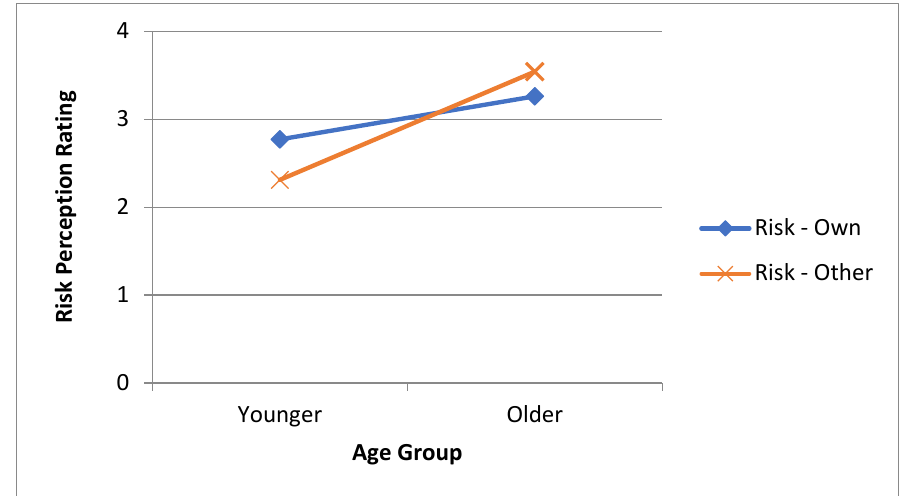
Figure 1. Means ratings for overall own risk and other risk ratings for the younger and older age groups.